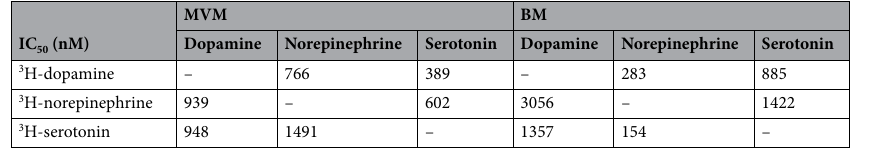
Table 2. IC 50 values (nM) for inhibition of 112 nM 3 H-dopamine, 332 nM 3 H-norepinephrine, and 100 nM 3 H-serotonin uptake by MVM and BM in the presence of increasing concentrations of unlabelled monoamines.